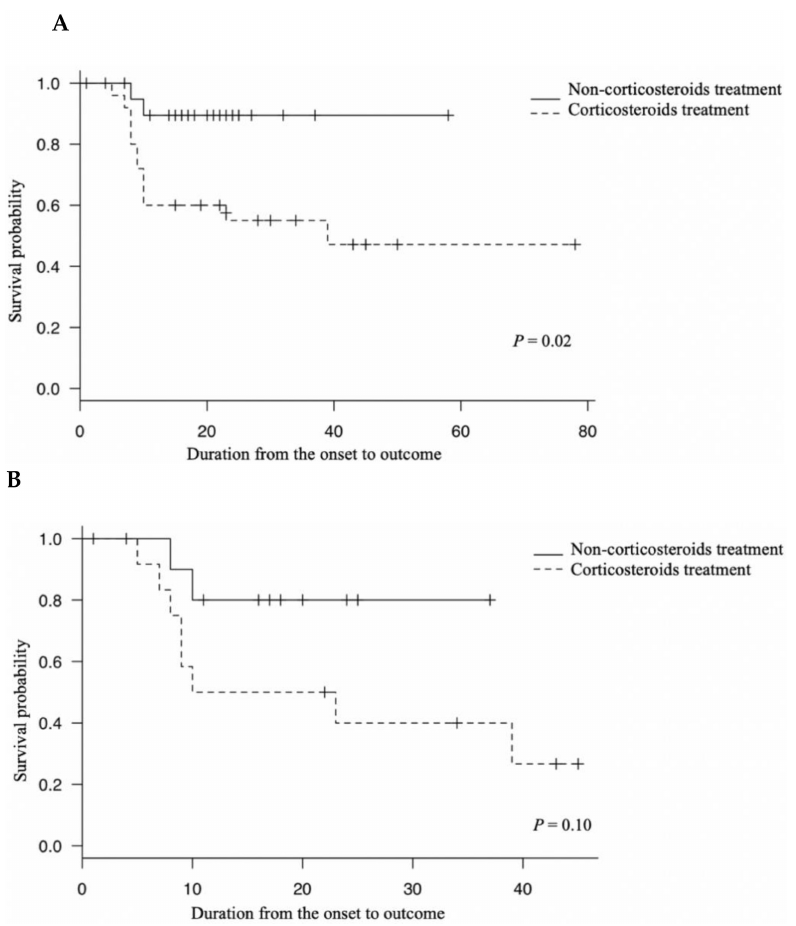
Figure 1. Kaplan–Meier curves for survival in the patients with severe fever with thrombocytopenia syndrome. ( A ) Survival curves in the corticosteroid-treated and the non-corticosteroid-treated groups ( p = 0.02 by log-rank test). ( B ) Survival curves in the corticosteroid-treated and the non-corticosteroid- treated groups after propensity score matching ( p = 0.10 by log-rank